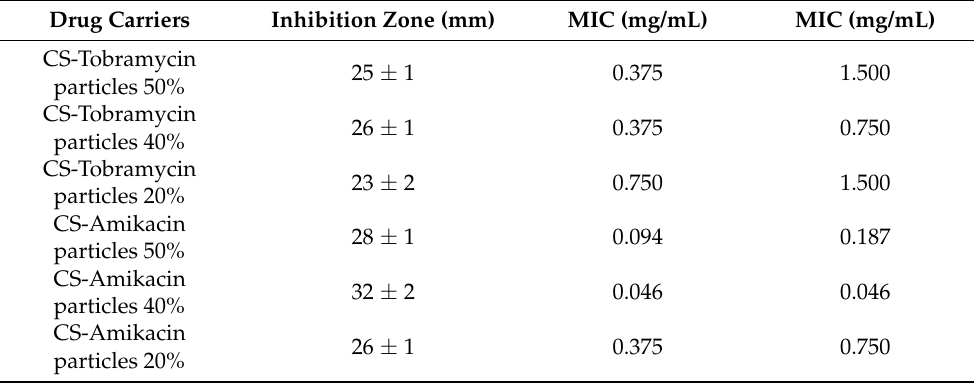
Table 3. Inhibition zone (mm), minimum inhibition concentration (MIC), and minimum bactericidal concentration (MBC) values of CS-Tobramycin and CS-Amikacin particles crosslinked at 50%, 40%, and 20% mole ratios against P. aeruginosa . Drug Carriers Inhibition Zone (mm) MIC (mg/mL) MIC (mg/mL) CS-Tobramycin 25 ± 1 0.375 1.500 particles 50% CS-Tobramycin 26 ± 1 0.375 particles 40%